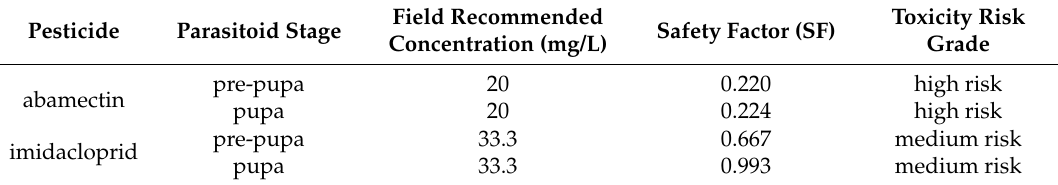
Table 6. The toxicity risk grade of abamectin and imidacloprid to pre-pupa and pupa of Encarsia formosa .